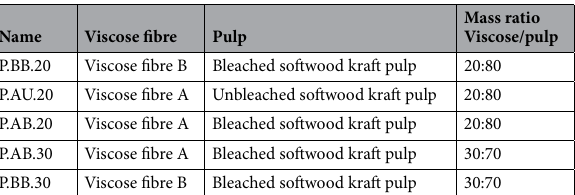
Table 2. List of produced laboratory pilot-scale nonwovens. PW stands for pilot web, VA/VB for viscose type and BSK/UBSK for the pulp grade.